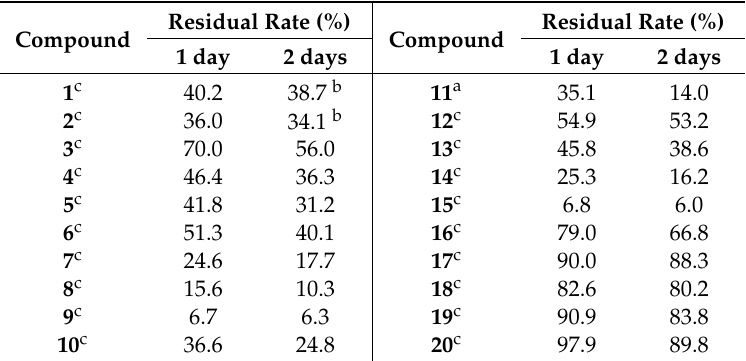
Table 2. The residual rate of the derivatives 1 – 20 after 1 or 2